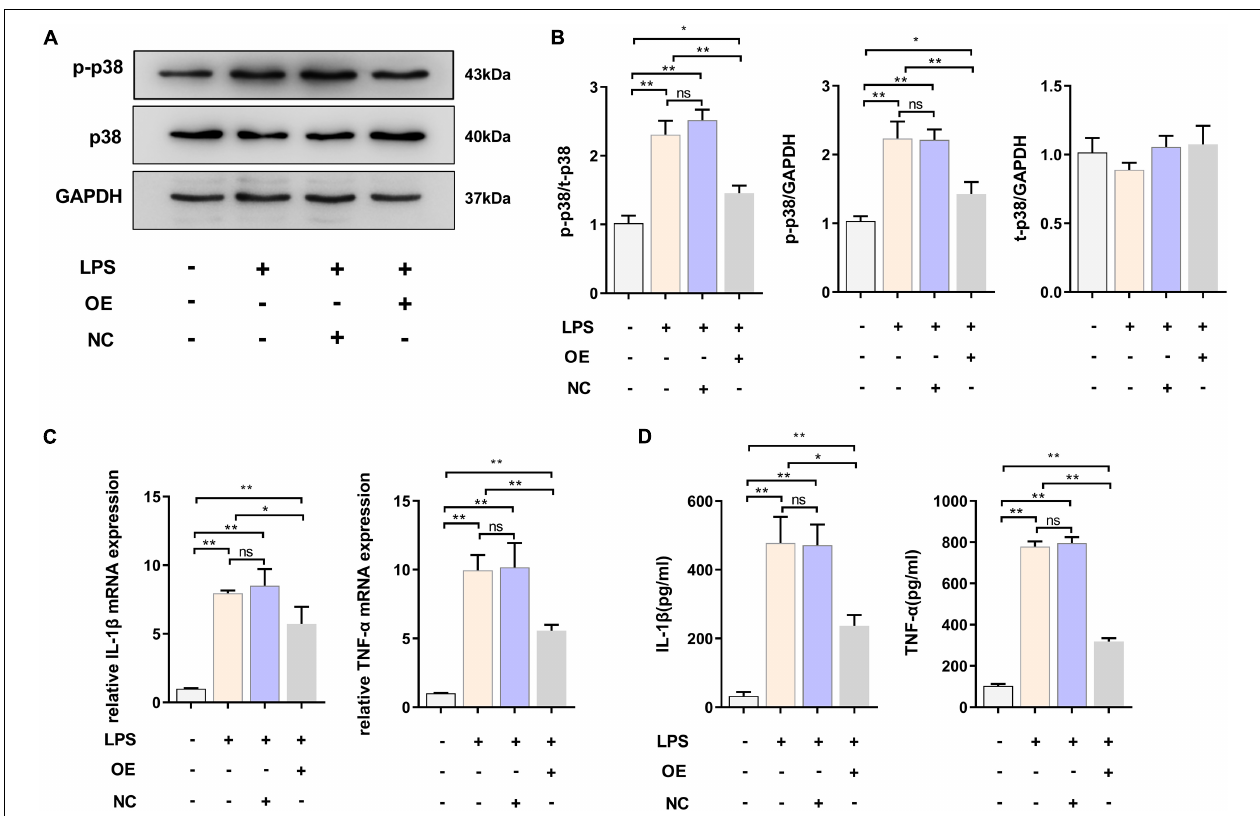
FIGURE 3 | Overexpressed TREM2 inhibits the P38 MAPK pathway and proinflammatory cytokines. (A,B) BV2 cells were transfected with plasmid 24 h, then the cells were incubated with LPS (1 µ g/ml) for 24 h. The expression level of p-p38 and p38 protein after transfection of plasmid was detected by WB ( n = 3/group), and the expression of p-p38 and p38 were analyzed by quantitative analysis of protein, the ratio of p-p38/p38 was shown ( F = 68.49). (C) The mRNA levels of the proinflammatory cytokines TNF- α ( F = 59.38) and IL-1 β ( F = 45.76) were determined using RT-qPCR ( n = 3/group). (D) The protein levels of the proinflammatory cytokines TNF- α ( F = 78.72) and IL-1 β ( F = 51.53) were determined using ELISA ( n = 3/group). NC stands for transfection of empty-plasmid. TREM2 OE stands for transfection of TREM2-plasmid. All the quantitative analysis of protein was done by Image J to calculate the gray value. Data are shown as the mean ± SE. The fold change is significant where * P < 0.05, ** P < 0.01. n = number of independent cell culture